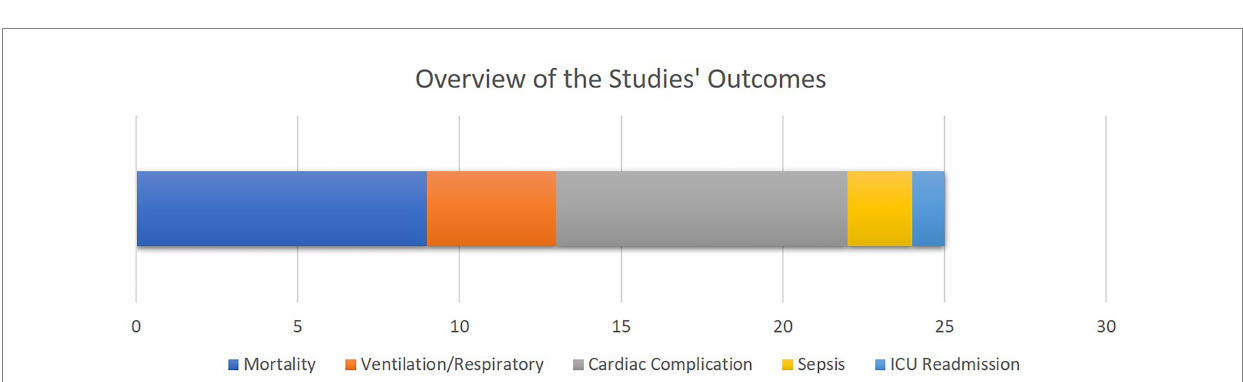
FIGURE 4 The overview of the outcomes of the selected studies. The bar chart shows how frequent each study outcome has been, with the X axis quantifying the number of studies. Note that some studies analyzed multiple outcomes.